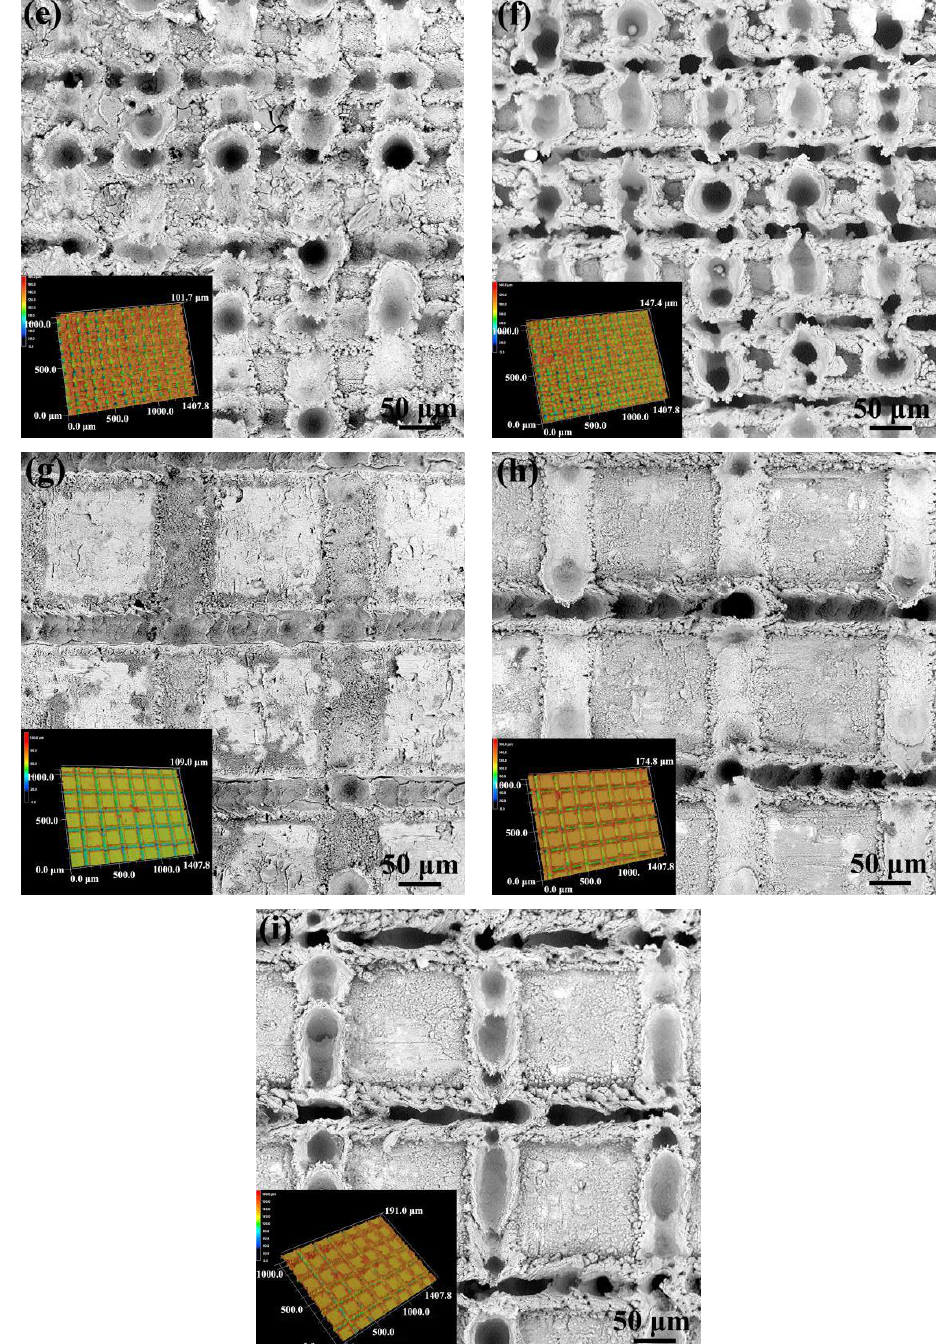
Figure 5. SEM micrograph and surface morphology of the Al alloy joining interface with different laser scanning distances and times: ( a ) d = 0.05 mm and n = 1, ( b ) d = 0.05 mm and n = 2, ( c ) d = 0.05 mm and n = 4, ( d ) d = 0.1 mm and n = 1, ( e ) d = 0.1 mm and n = 2, ( f ) d = 0.1 mm and n = 4, ( g ) d = 0.2 mm and n = 1, ( h ) d = 0.2 mm and n = 2, and ( i ) d = 0.2 mm and n = 4 (inset image showing the 3D morphology analyzed by LSCM with magnification of 400 × ).